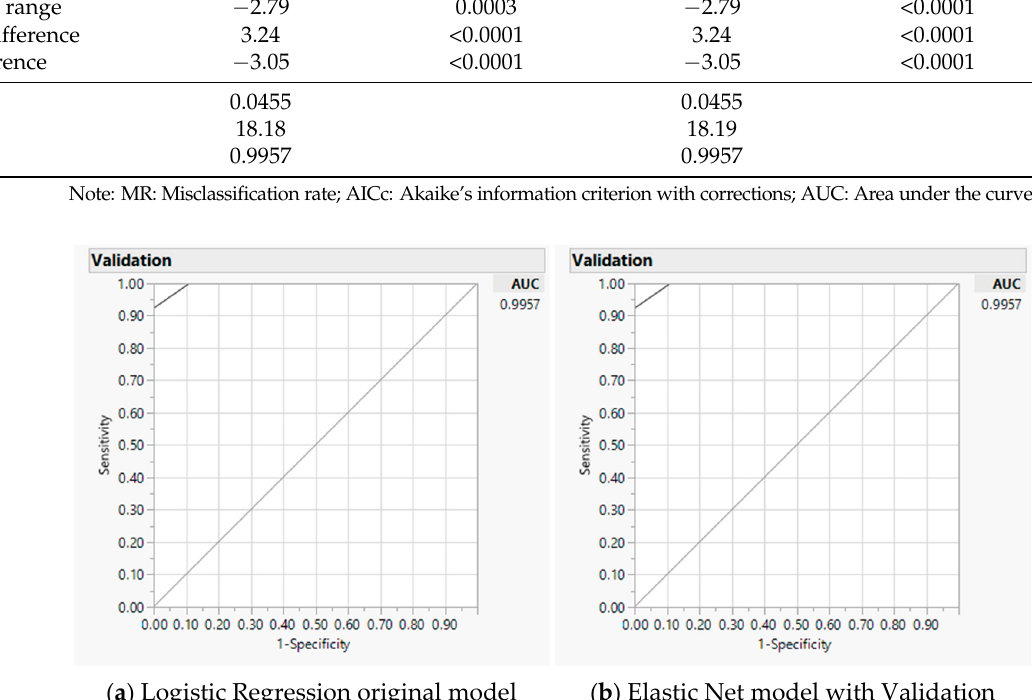
Figure 5. Predicting accuracy of total calories analyses using mobile application against Food Frequency Questionnaire: Area under the receiver operating characteristic curve (AUC) for baseline logistic regression model ( a ) and Elastic Net with validation model ( b ).